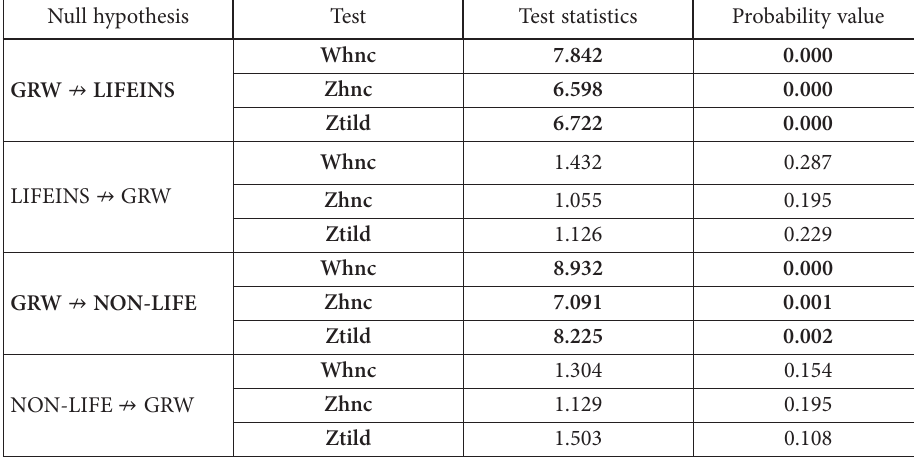
Table 8. Dumitrescu and Hurlin (2012) causality test (source: own